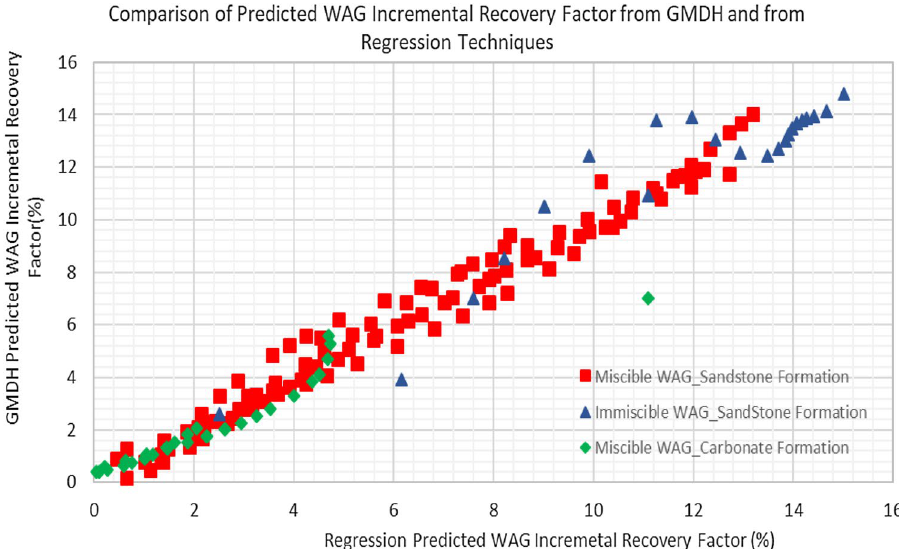
Fig. 20 Comparison between GMDH and regression model prediction